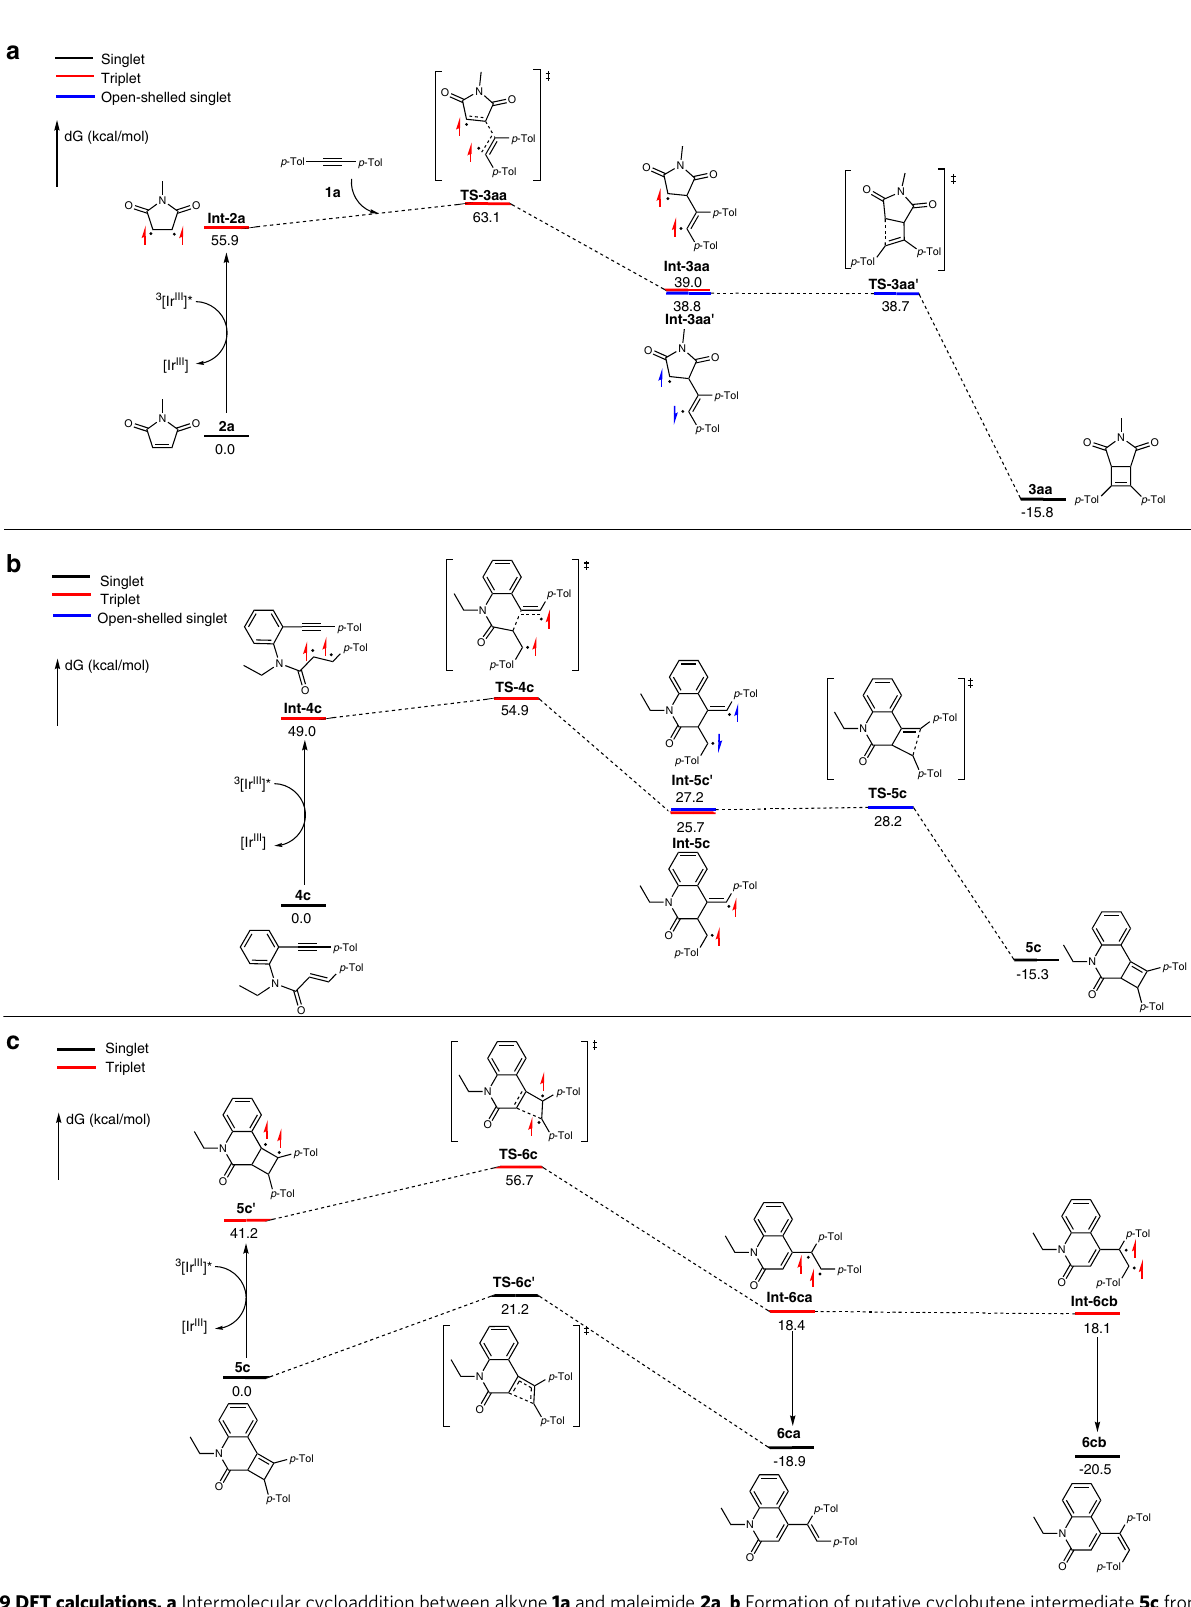
Fig. 9 DFT calculations. a Intermolecular cycloaddition between alkyne 1a and maleimide 2a . b Formation of putative cyclobutene intermediate 5c from the intramolecular reaction of 4c . c Formation of 1,3-dienes from 5c